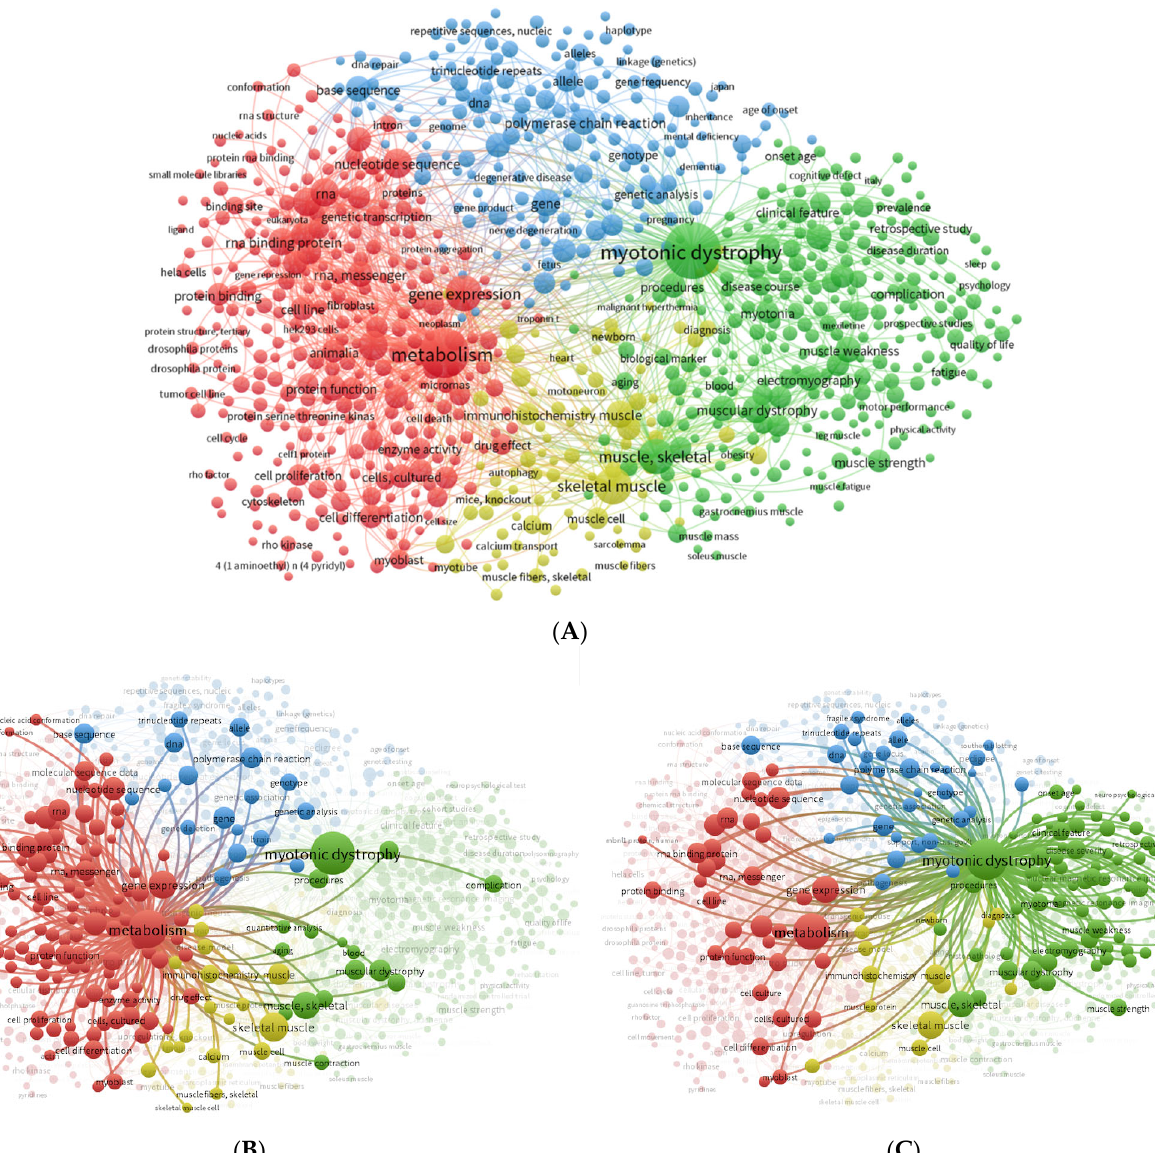
Figure 2. Keyword network visualization map. ( A ) Global network of the co-occurrence of all keywords co-. ( B ) Metabolism co-occurrence network. ( C ) Myotonic dystrophy co-occurrence network. The co-occurrence network visualization map was created using VOSviewer (https://www. vosviewer.com/ (accessed on 21 December 2022). The node size reflects the occurrence of the